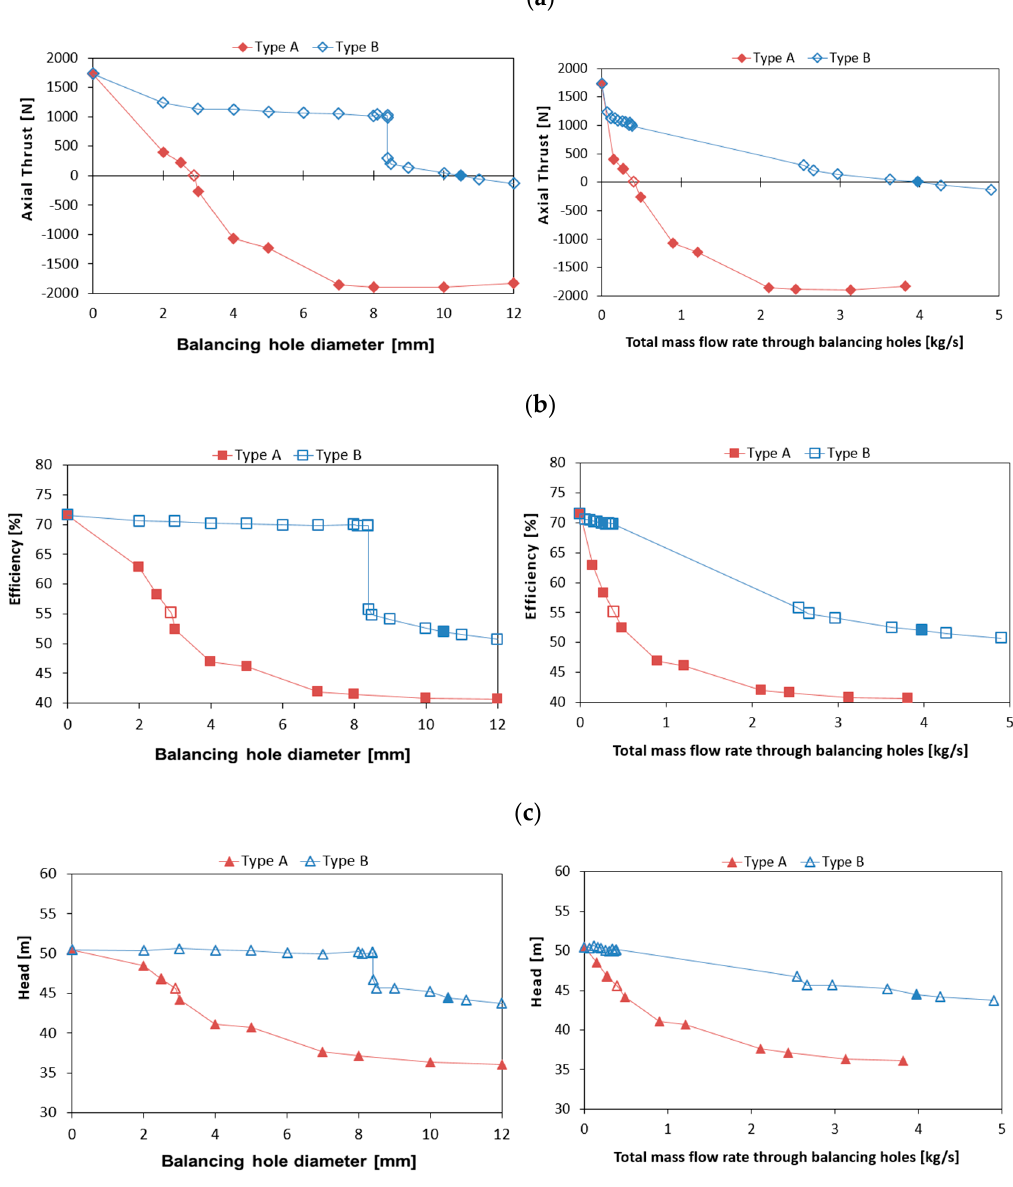
Figure 13. Changes in the axial thrust and performance according to the diameter of balancing holes and the flow changes through the balancing holes of pump models with Type A and B balancing holes.